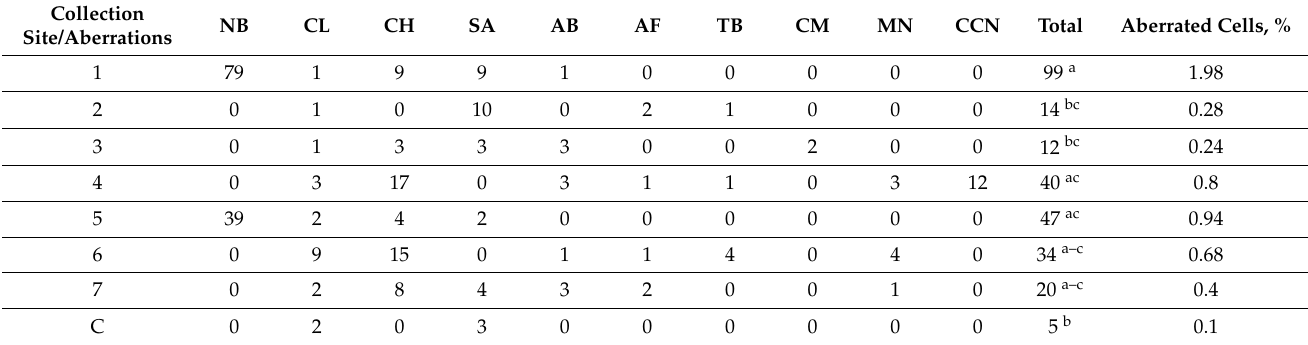
Table 1. Aberrations in the cells of A. cepa root meristem after soaking in the water from investigated water bodies (by 5000 cells in every sample).